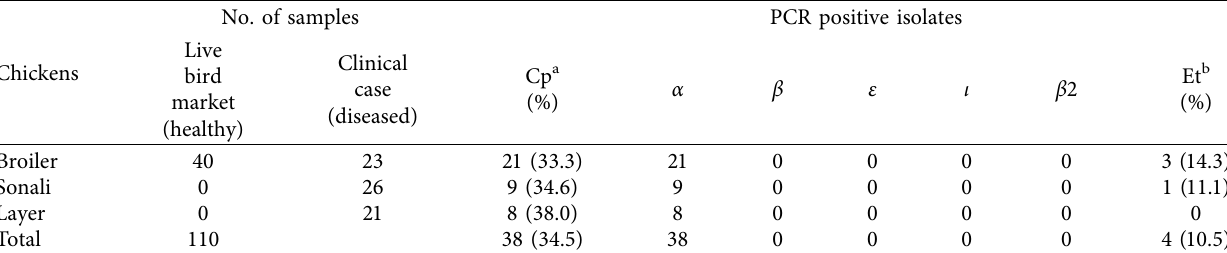
Table 2: Distribution of C. perfringens isolates and its toxins from diferent chickens.